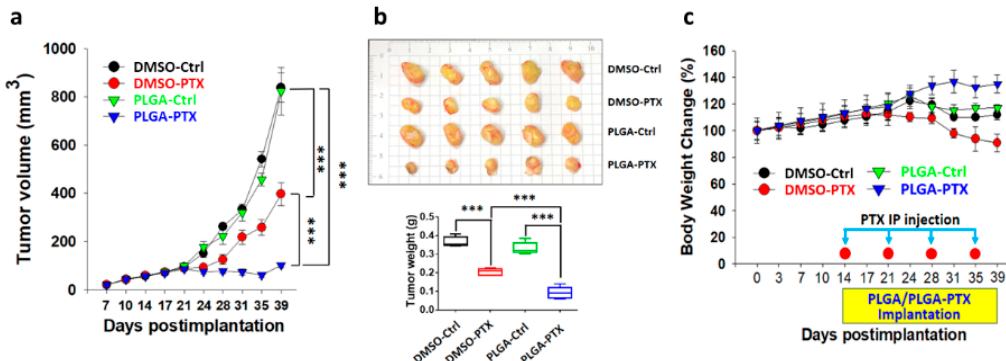
Figure 6. PTX-loaded PLGA nanofibrous membranes could enhance antitumor efficacy in vivo. ( a ) Tumor growth curve. The widths and lengths of MDA-MB-231-Luc tumors were measured, then tumor volumes were calculated using the following formula: volume = width 2 × length × 0.5236. Data are presented as tumor volumes in each group ( n = 5 tumors/group). ( b ) Tumors were excised and photographed from MDA-MB-231 xenografts after 39 days (upper panel), and the mean tumor weights of different treatment groups are shown (lower panel). ( c ) Weight changes of the mice in each group. Data are expressed as mean ± SD. *** p < 0.001. DMSO-Ctrl, DMSO control; DMSO-PTX, free-paclitaxel in DMSO; PLGA-Ctrl,